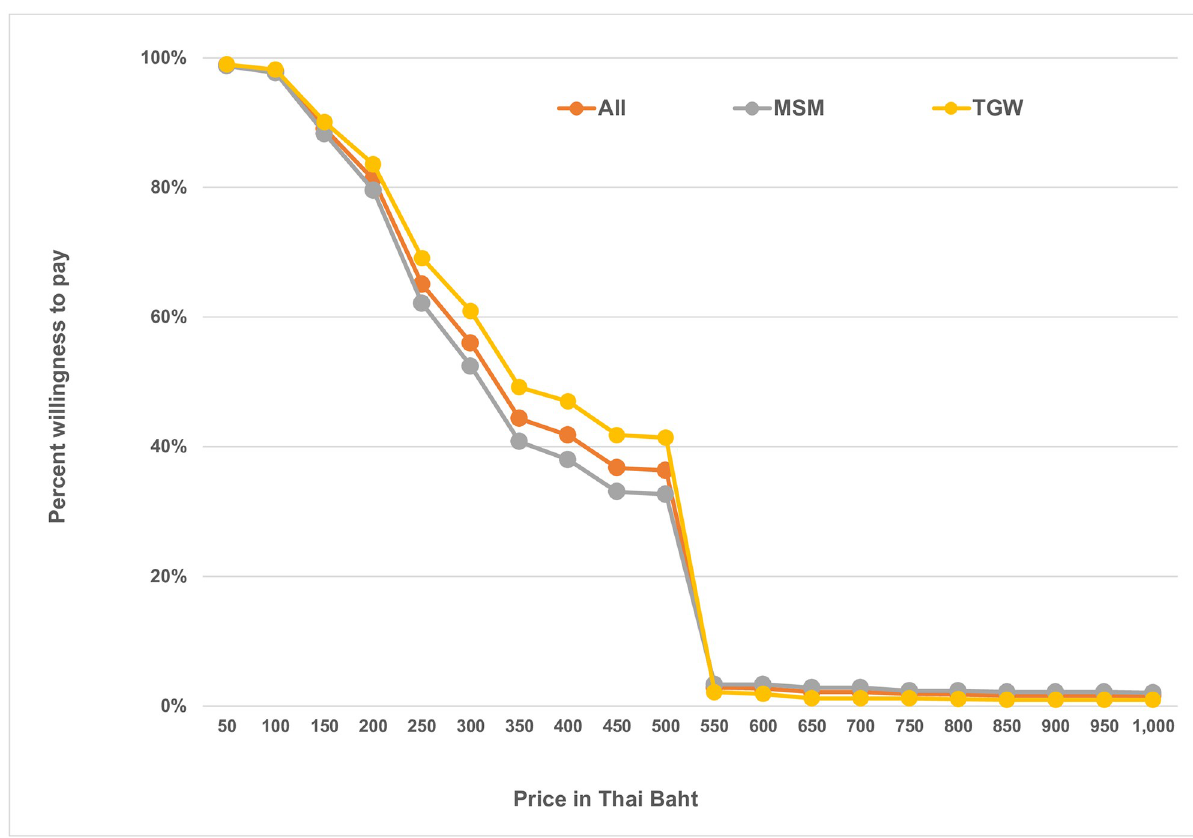
Fig 1. Willingness to pay for HIVST among potential MSM and TGW